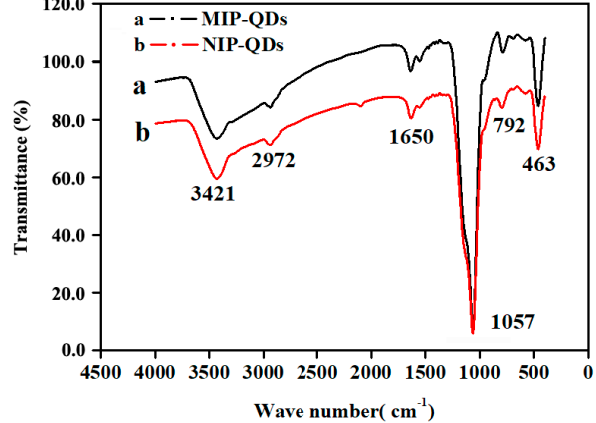
Figure 2. FT-IR spectra of MIP-QDs and NIP-QDs.